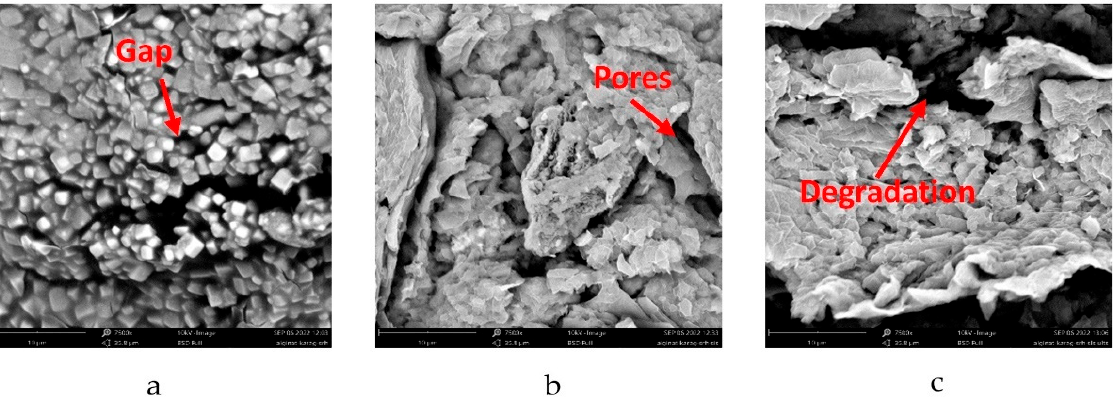
Figure 4. SEM images of citronella-oil-encapsulated beads: ( a ) without SDS/non-UTS; ( b ) SDS/non- UTS; and ( c ) SDS/UTS.